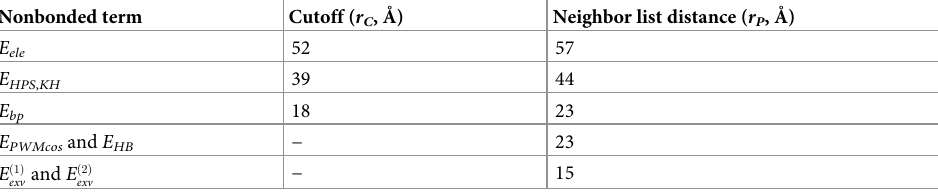
Table 2. Default values for the nonbonded cutoff and pair-list distances.